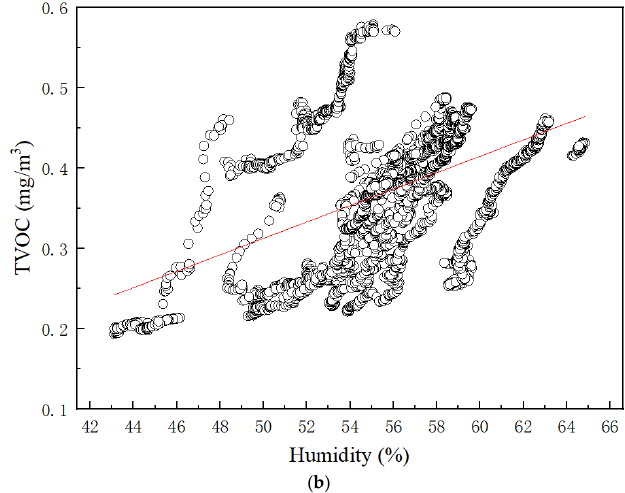
Figure 18. Correlation between TVOC and other parameters. ( a ) Correlation between TVOC and temperature. ( b ) Correlation between TVOC and humidity.